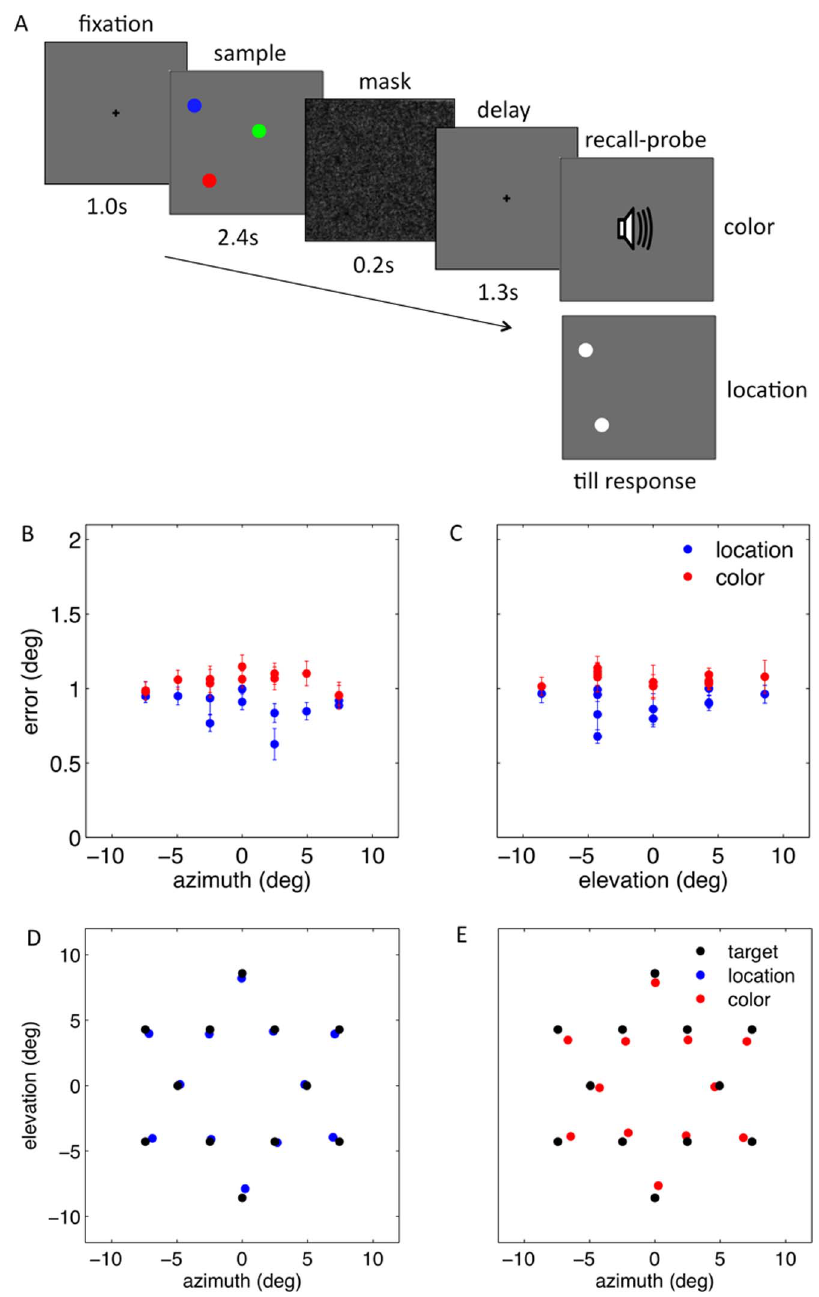
Figure 5. Probing procedure affects spatial recall. (A) Trial structure. The target to be recalled was identified either by presenting the non- target items (location-probe), or by voicing the target color (color-probe). The memory load was always three. (B) The error standard deviation is shown as a function of target azimuth, following location (in blue) and color-probes (in red), and (C) as a function of target elevation. Variable error was smaller for the location than the color-probe condition. This difference was largest for targets halfway between the center and the boundaries of the display. (D) Following location-probes, participants underestimated the target distance from the center of the screen less prominently than (E) following color-probes. (see also Figures S2A,B; Figures S3A-D, Figures S4A,B). the probe effects arise at recall rather than reflecting changes in encoding strategies.